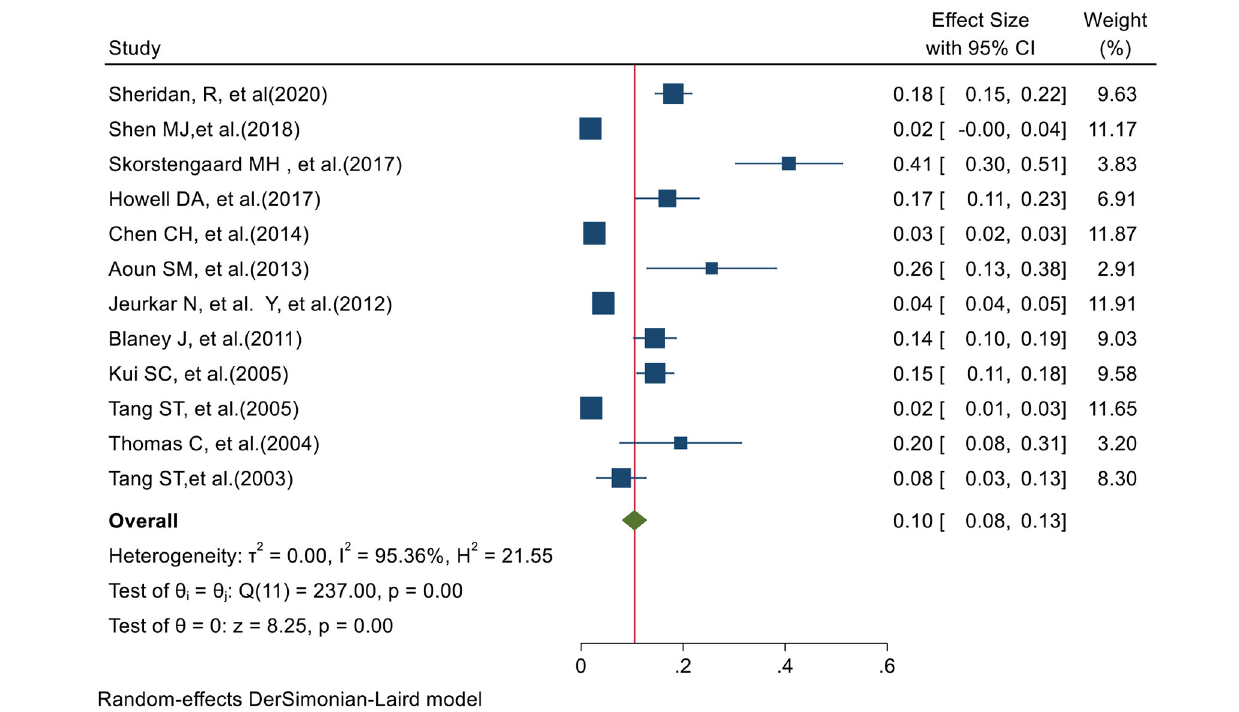
FIGURE 4 | Forest plot for the prevalence of Hospice-based